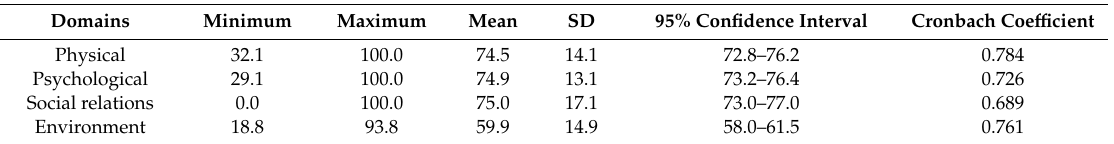
Table 3. Scores of the World Health Organization Quality of Life abbreviated version (WHOQOL-BREF) domains in prison o ffi